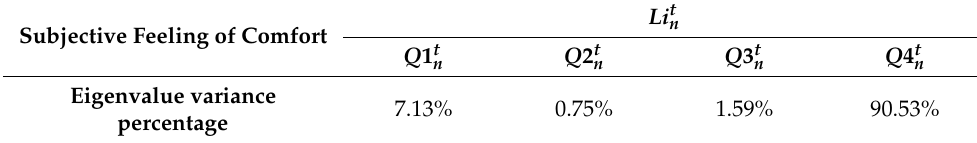
Table 3. Results of principal component analysis of psychological comfort index.